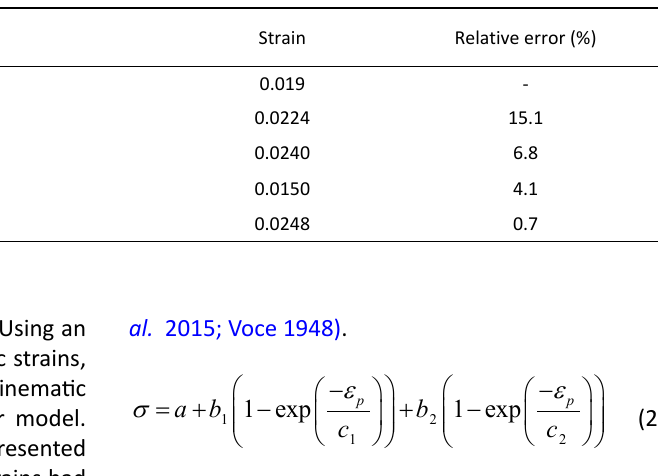
Fig. 1: The MSW sample modeling Table 2: Results of the mesh sensitivity análisis